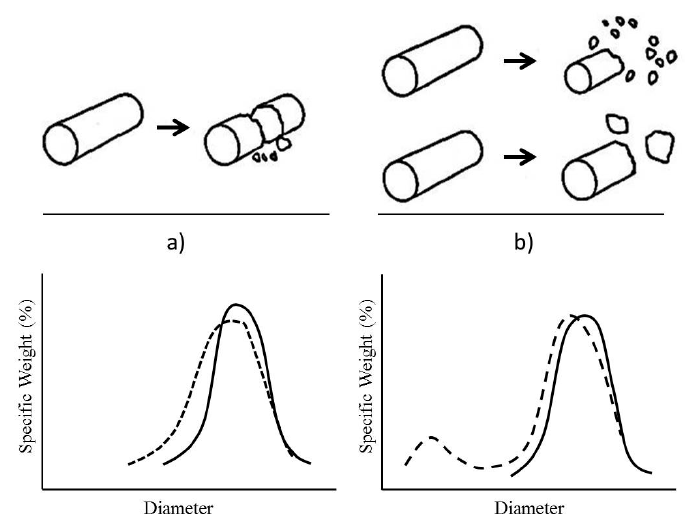
Figure 13. Two di ff erent breakage mechanisms of pellets. ( a ) fragmentation, ( b ) abrasion and their particle size distribution curves adapted from